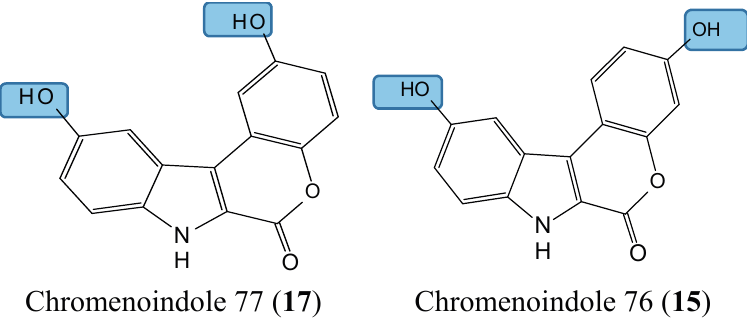
Figure 5. Chemical structures of chromenoindole analogs.